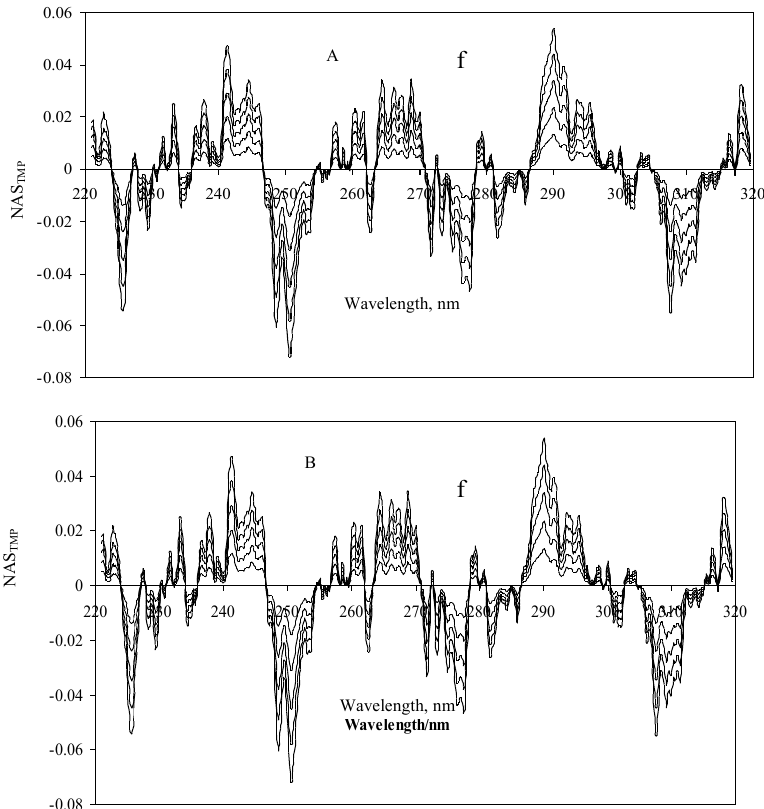
Figure 5. ( A) NAS and ( B ) NAS spectra of binary mixtures of SMX ( 10 µmol L -1 ) SMX TMP and TMP ( 20 µmol L -1 ) after addition of 0,5,10,15 and 20 µmol L -1 SMX (a-f) and 0, 15, 30, 45 and 60 µmol L -1 TMP (a-f) at pH